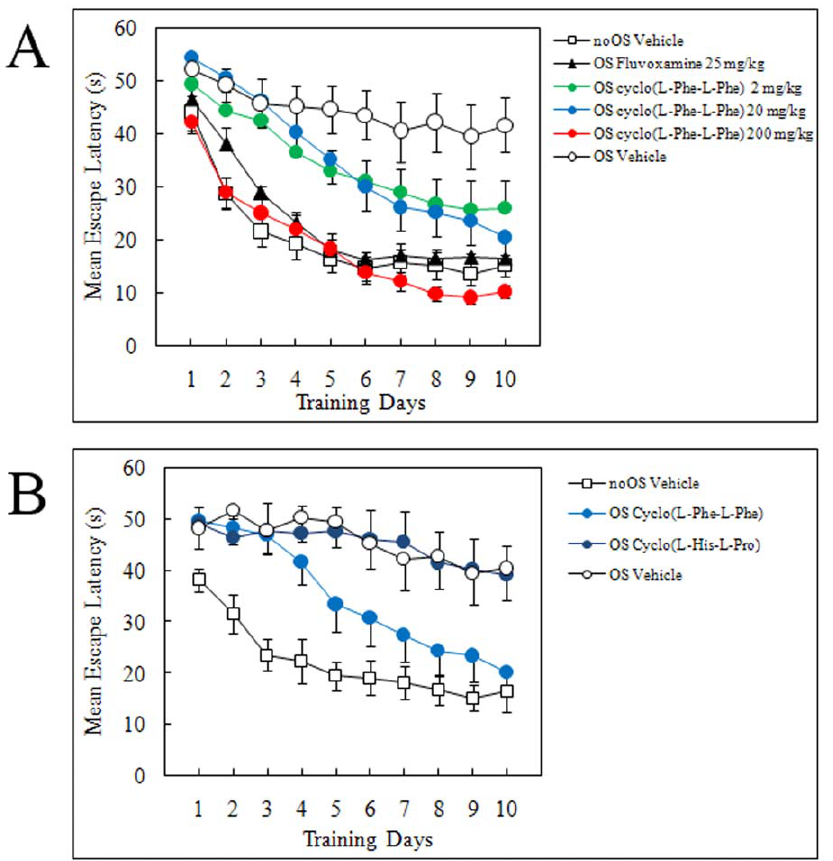
Figure 5. Effects of cyclo( L -Phe- L -Phe) and cyclo( L -His- L -Pro) on escape latency in the water maze test using depressed mice previously subjected to repeated open swimming (OS). (A) Cyclo( L -Phe- L -Phe) was orally administered at doses of 2, 20 and 200 mg/kg. Experimentally naı¨ve male C57BL/6N mice were used. Vehicle control mice treated with/without training trials were represented as the OS vehicle and nonOS vehicle, respectively. The selective serotonin reuptake inhibitor (SSRI) fluvoxamine maleate (25 mg/kg, i.p.) was used as the positive control. (B) Cyclo( L -Phe- L -Phe) and cyclo( L -His- L -Pro) were orally administered at dose of 20 mg/kg. All values are mean 6 standard error (n=10–13